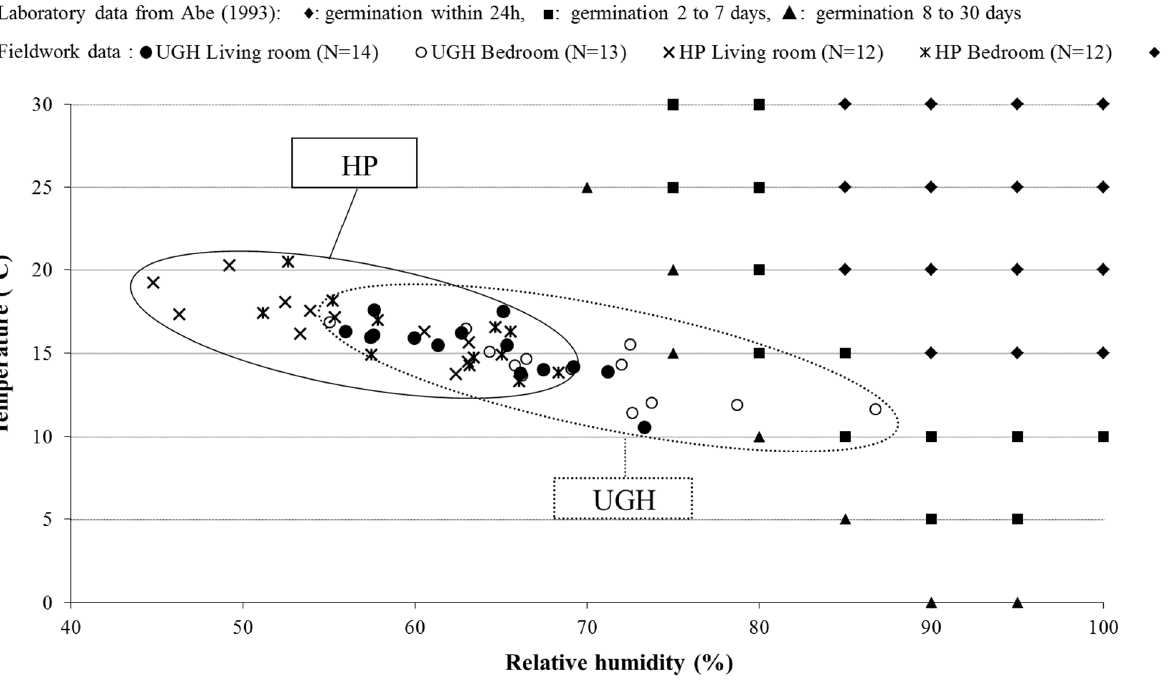
Figure 3. Climograph with germination of Eurotium herbariorum spores; fieldwork data compared to laboratory data (adapted from